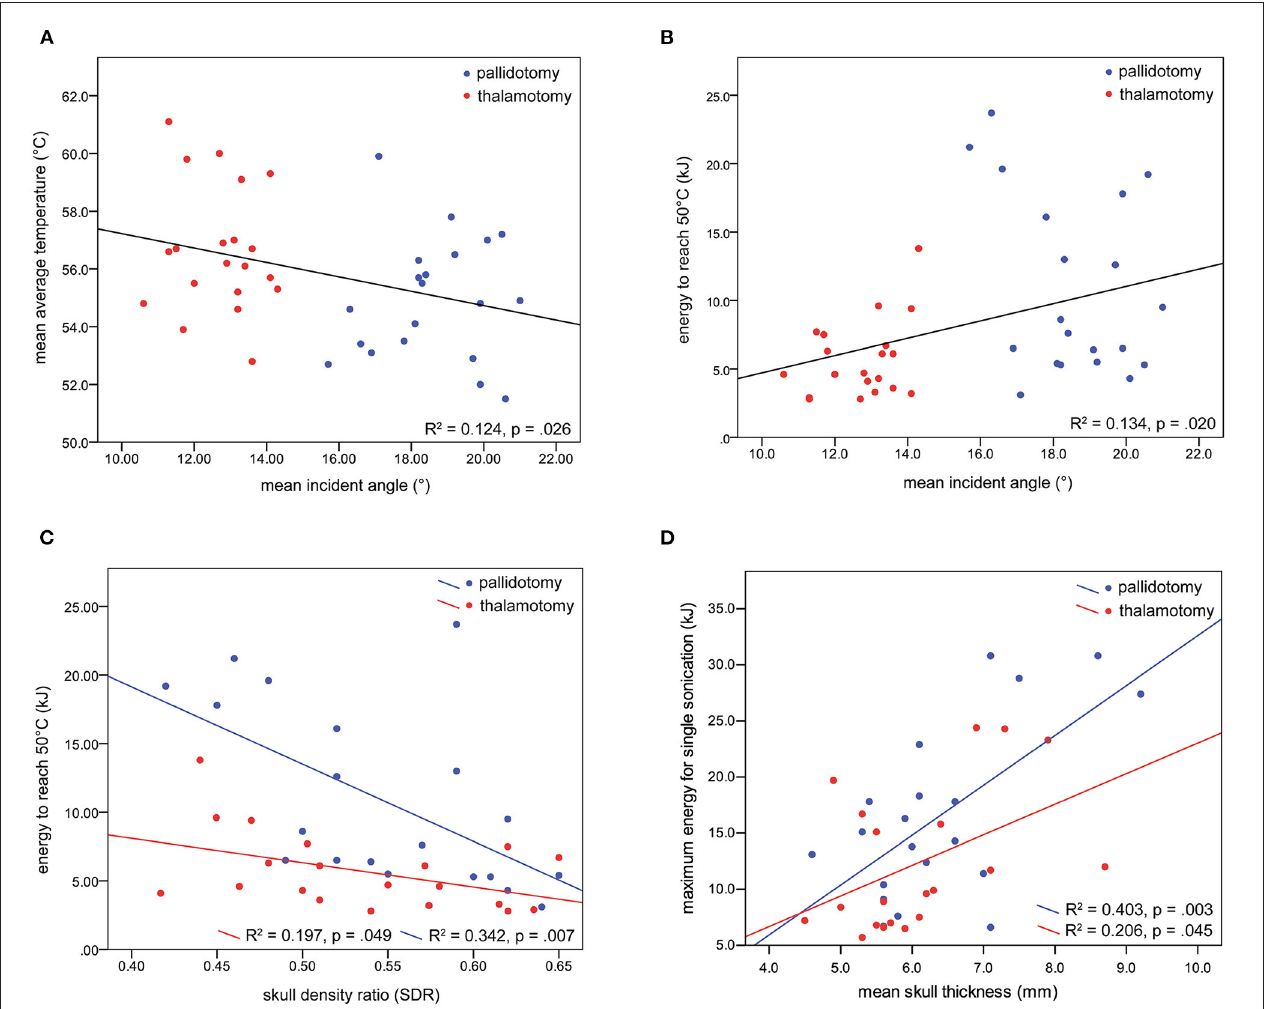
FIGURE 3 | Univariate regression models were developed. A lesser mean incident angle was associated with a higher maximum average temperature reached (A) , and less energy needed to reach 50 ◦ C (B) . A lower SDR was correlated with more energy needed to reach 50 ◦ C, for thalamotomy and for pallidotomy, nearly to a greater degree for pallidotomy (C) . Greater skull thickness was associated with greater energy for a single sonication (D)